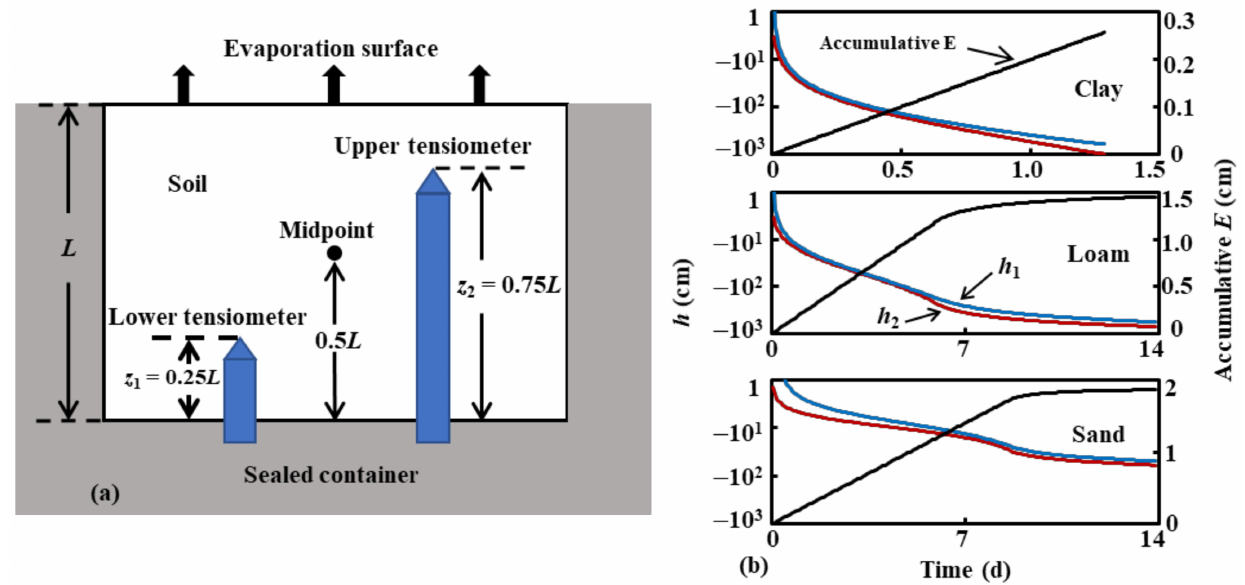
Figure 1. Simplified evaporation experiments: ( a ) sketch of the equipment and ( b ) synthetic numerical